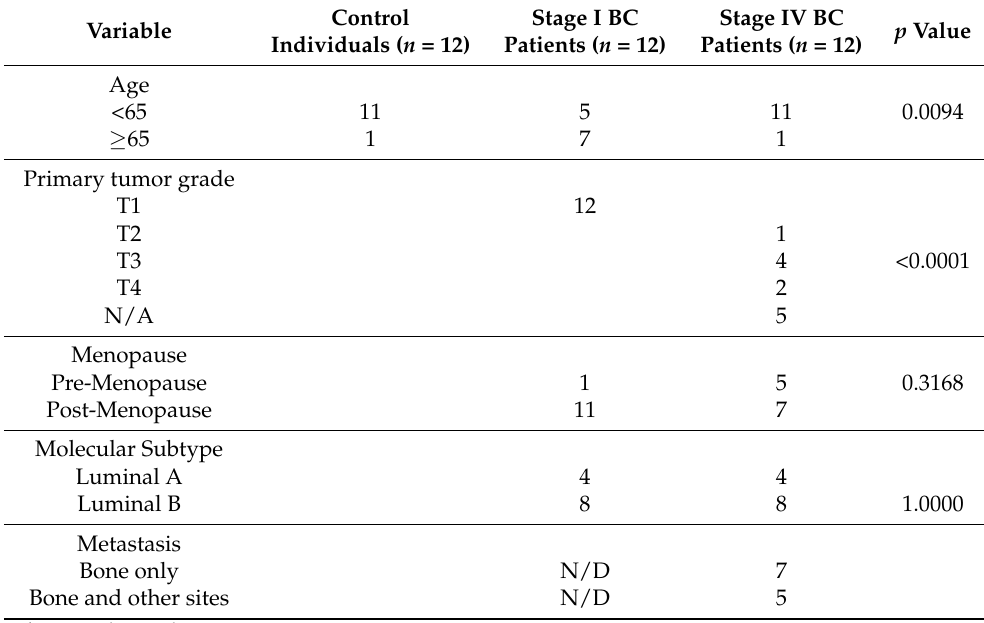
Table 1. The clinical parameters of control individuals and BC patients included in our study. Variable